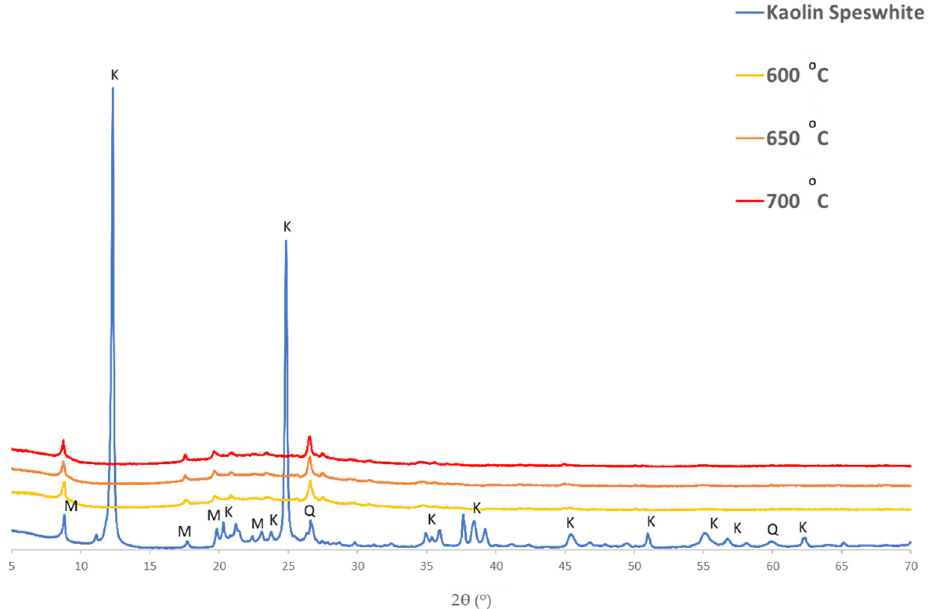
Figure 3. XRD patterns for Kaolin Speswhite and its calcined products in 600, 650 and 700 °C (K: Kaolinite M: Mica minerals Q: Quartz).